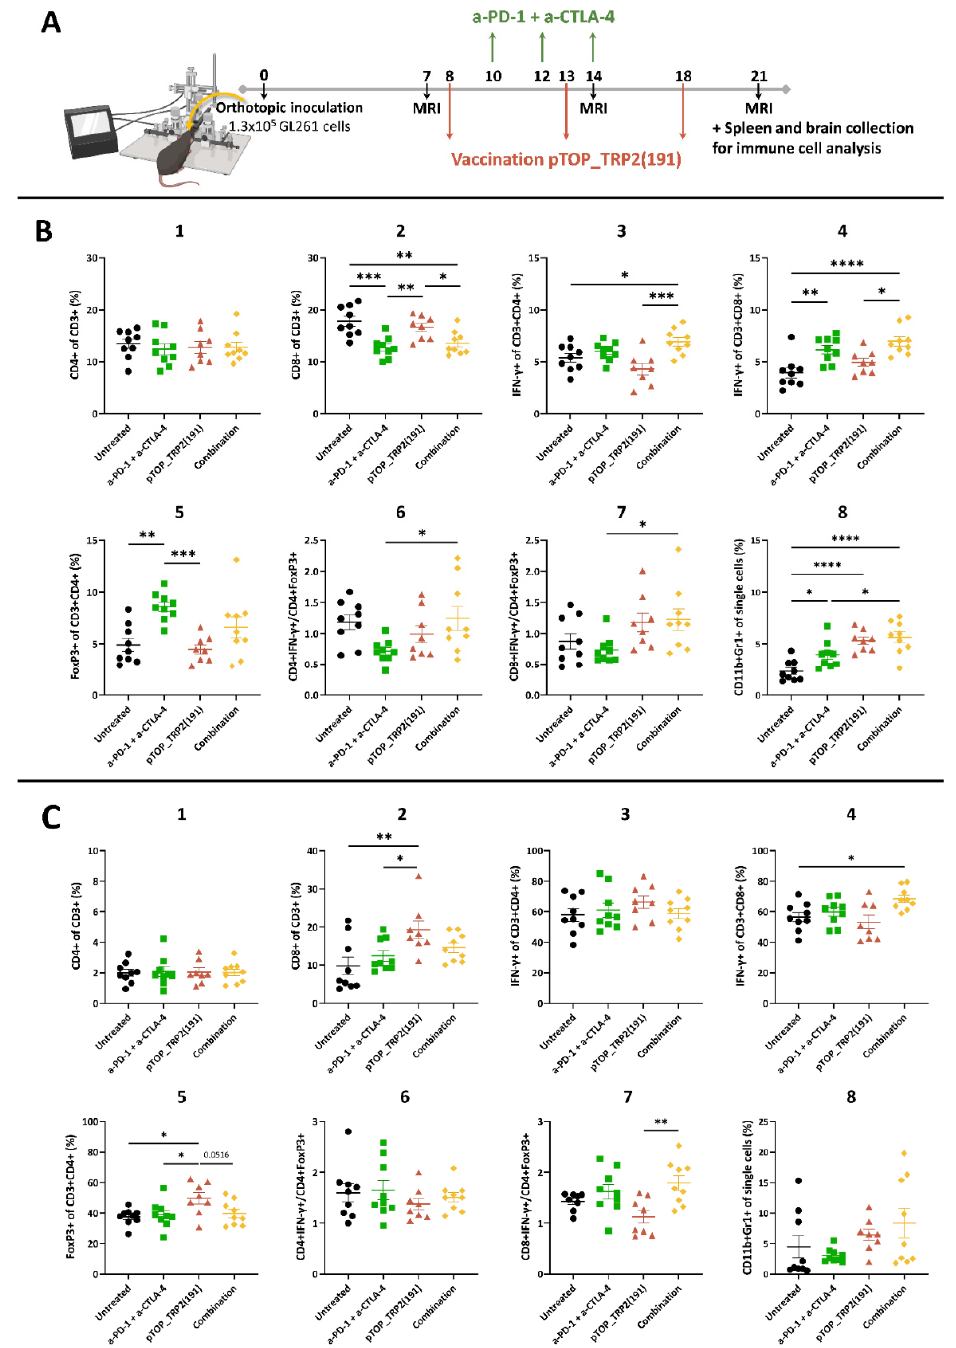
Figure 3. Immune cell populations analysis in the spleens and brains 21 days after tumor implantation. ( A ) Schematic protocol of experiments. Timing is expressed in days. ( B ) FACS analysis of immune cells in the spleens on day 21. ( C ) FACS analysis of immune cells in the brains on day 21. Values are mean ± SEM; n = 8–9. Statistical analyses were performed using one-way ANOVA with Dunnet’s multiple comparison test (* p < 0.05; ** p < 0.01; *** p < 0.001, **** p < 0.0001, compared to the specified group). Untreated: black circle; anti-PD-1 + anti-CTLA-4: green square; pTOP: red triangle; combination: yellow